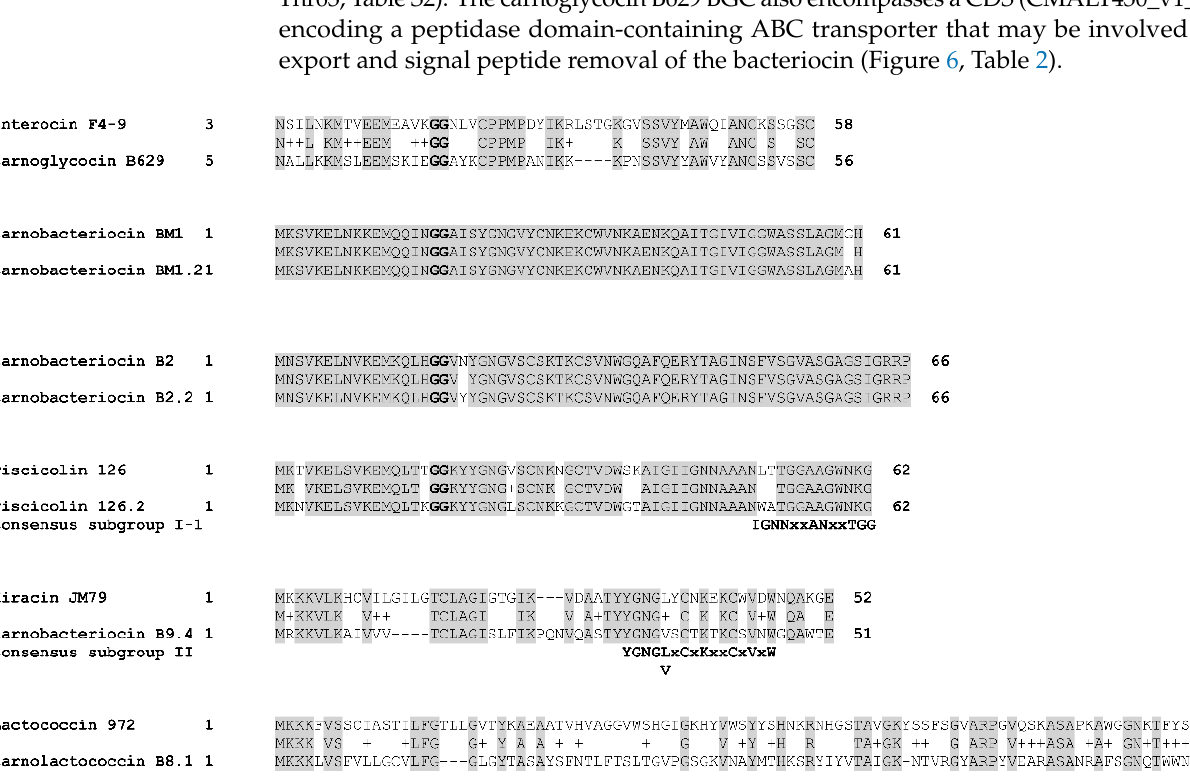
Figure 7. Alignment of bacteriocins homologs. The alignment was performed with BLASTp by using the BLOSUM62 matrix. The double glycines of the leader peptides are indicated in bold. The consensus sequences described for class IIa bacteriocins by [57] are indicated below the alignments. Identical amino acids are shaded in grey. Chemically similar amino acids are connected by a “+” symbol.